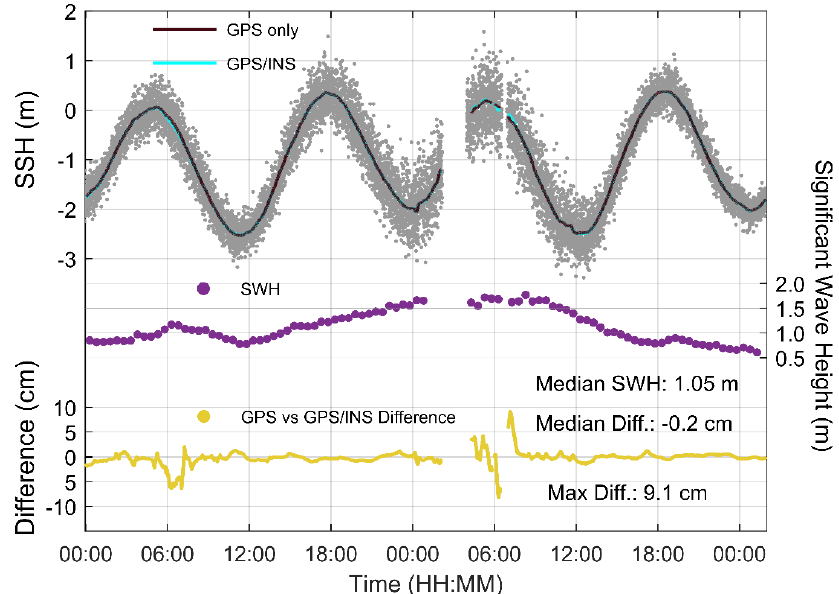
Figure 6. Inter-comparison between GPS only and GPS / INS solutions; Grey dots show the 15 s sub-samples from raw 2 Hz GPS / INS solutions; Black and cyan lines show respectively the 25-min moving mean solutions from GPS only and GPS / INS (note these two lines are largely indistinguishable in the top panel); Purple dots show SWH computed from raw SSH solutions over a running 30-min window for the deployment; Yellow line shows the di ff erence between GPS only and GPS / INS SSH solutions.